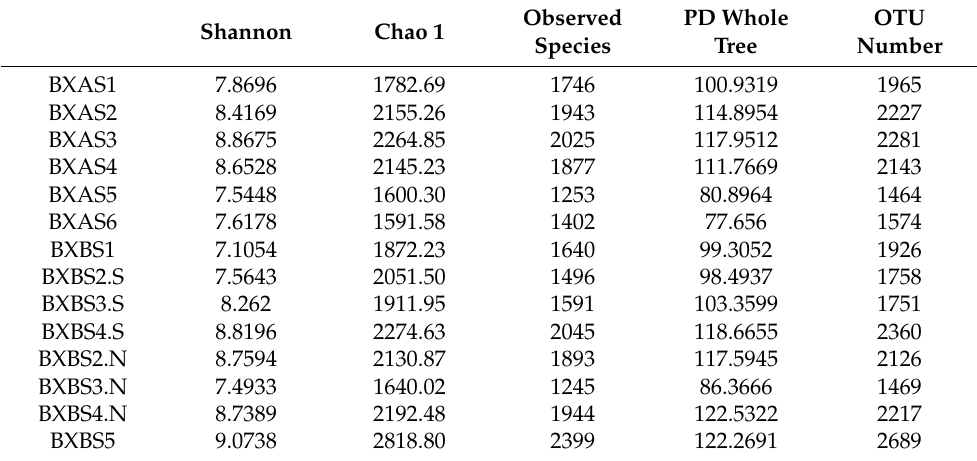
Table 2. Alpha diversity of